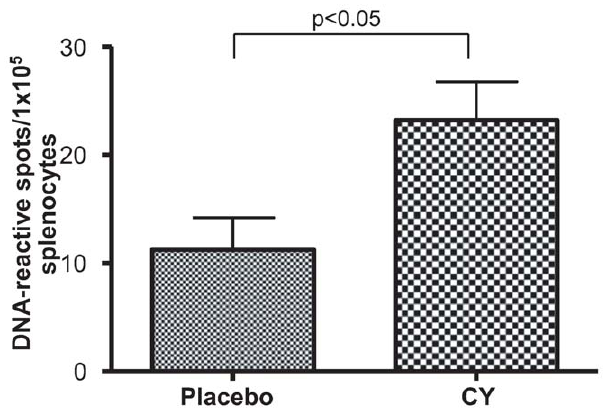
Figure 3. ELISpot assay to enumerate the DNA-reactive B cells. Five BALB/c mice were treated with CY and five with PBS. Student’s t test was used to determine the significance between the groups. A significant increase in the DNA-reactive cells was observed in CY-treated mice (p , 0.05).